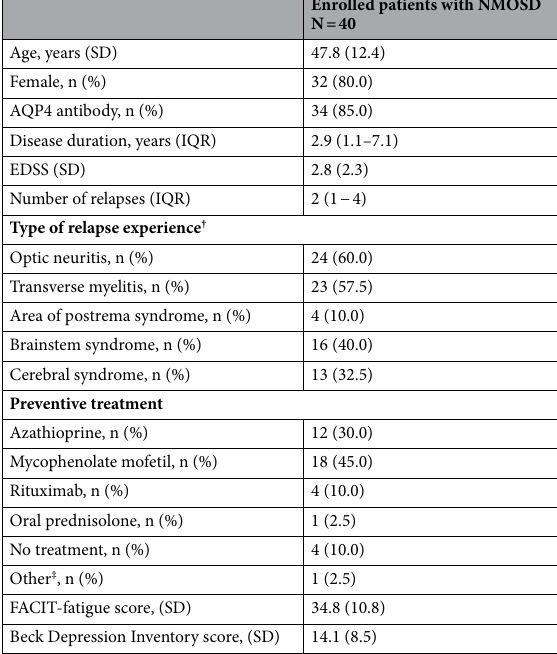
Table 1. Clinical characteristics of enrolled patients with neuromyelitis optica spectrum disorder. NMOSD neuromyelitis optica spectrum disorder, SD standard deviation, IQR interquartile range, AQP4